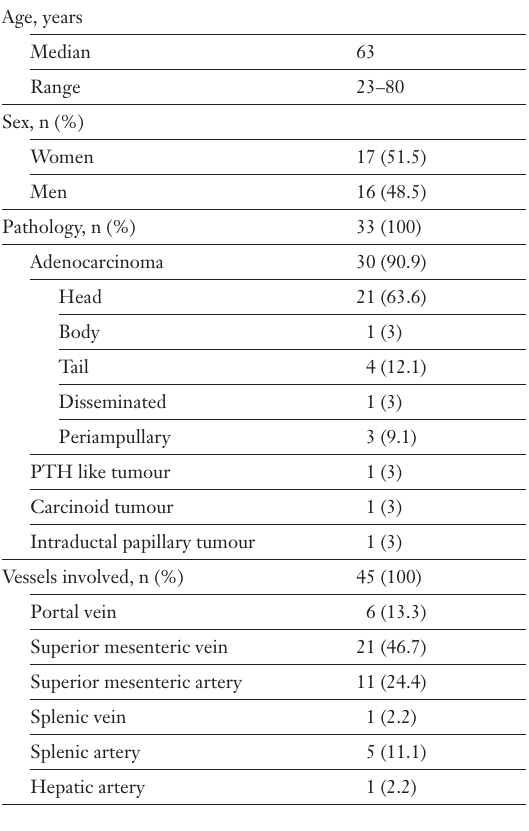
Table 3 Comparison of CT, EUS, US, and angio- graphy in the detec- tion of vascular invasion (n =